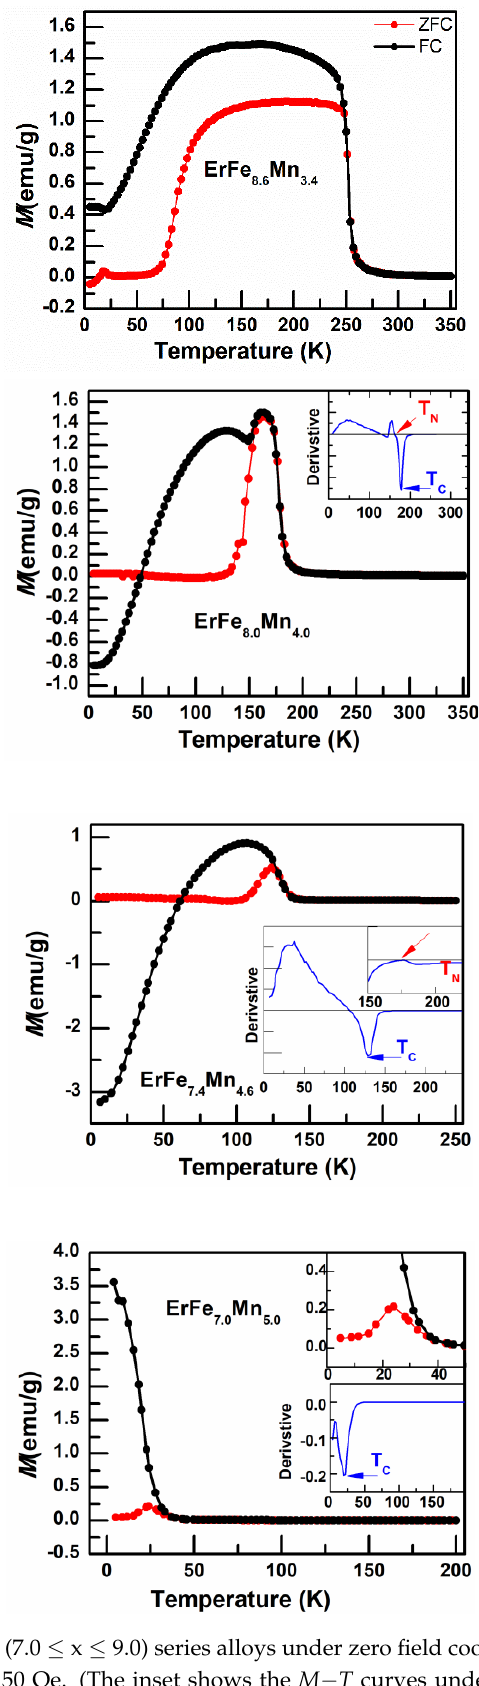
Figure 3. M − T curves for ErFe x Mn 12−x (7.0 ≤ x ≤ 9.0) series alloys under zero field cooling (ZFC) and field cooling (FC) conditions, H = 50 Oe. (The inset shows the M-T curves under FC after differentiation.) In the YFe x Mn 12−x -series (6.0 ≤ x ≤ 8.8) samples, as the proportion of Fe decreased, the T C of the alloy rapidly decreased and the T N slowly increased; the antiferromagnetic exchange magnetic ordering temperature of Mn-Mn